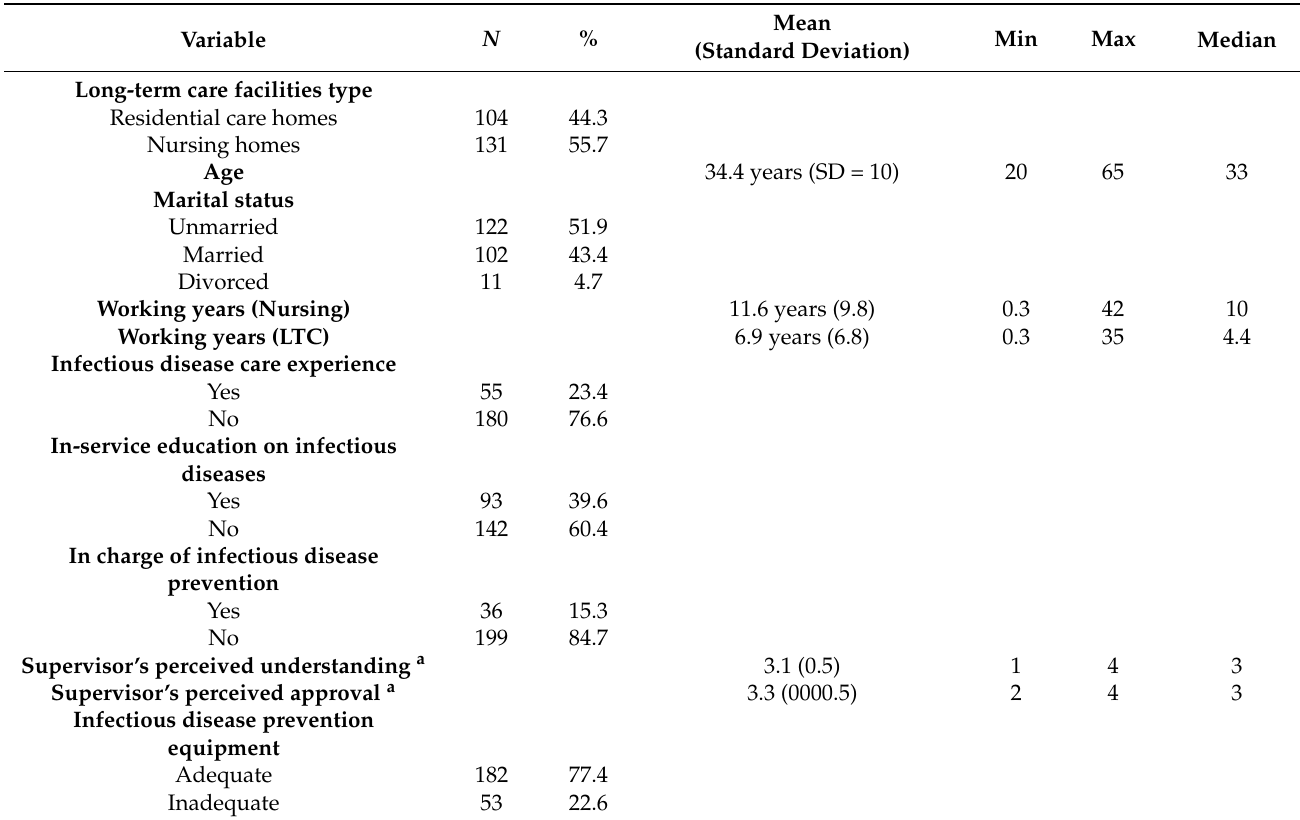
Table 1. Demographic characteristics of long-term care facility nurses ( N =